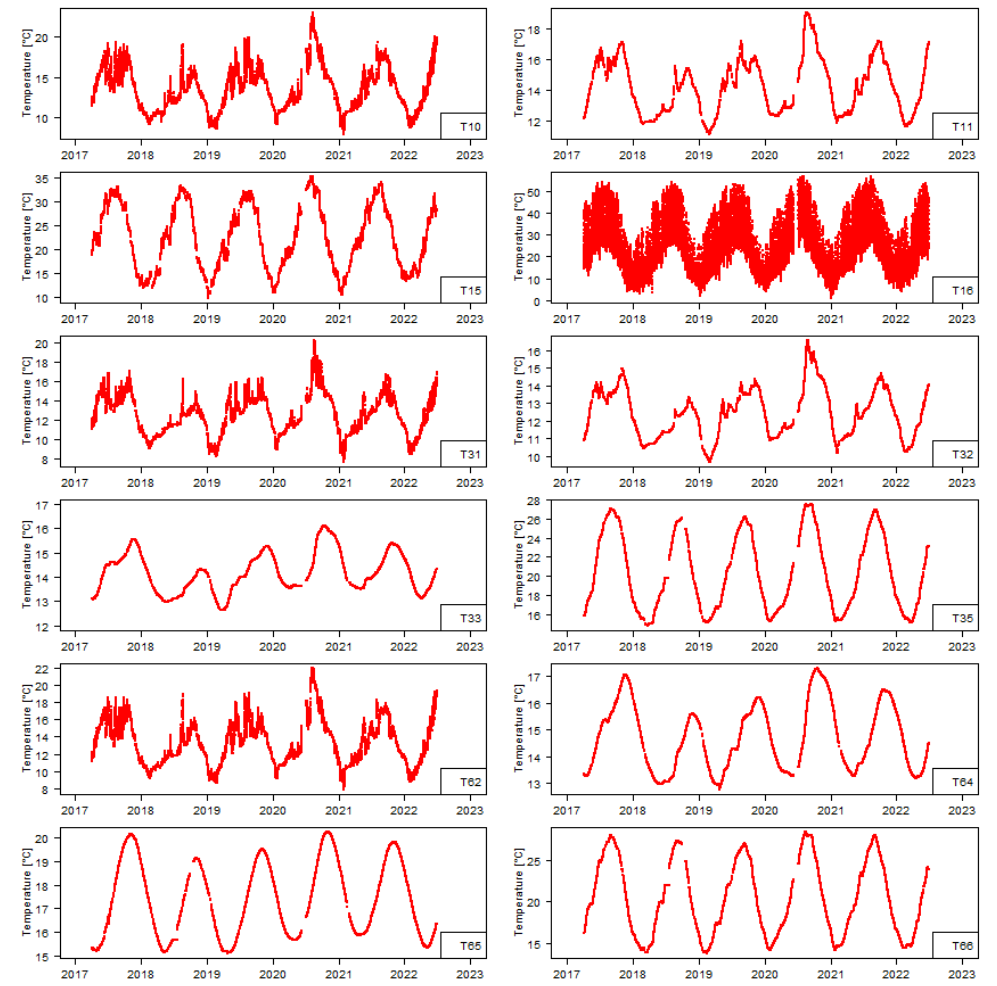
Figure 10. Temperatures in the dam body recorded between April 2017 and June